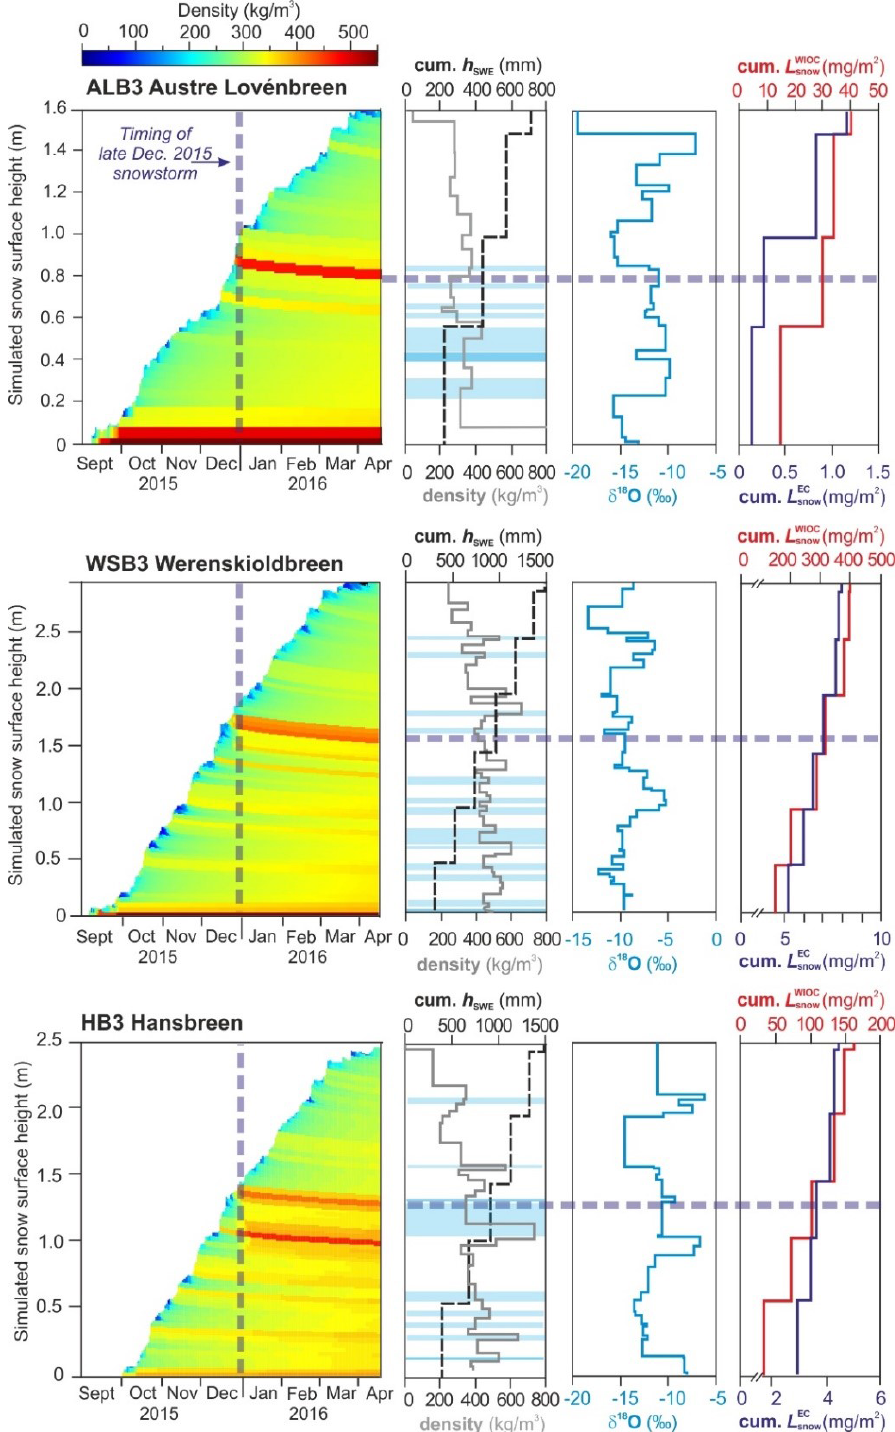
Figure 8. Simulated evolution of the snowpack from September 2015 to April 2016 at three glacier sites on Spitsbergen, compared with measured profiles of density, cumulative h SWE , δ 18 O, as well as cumulative L EC snow and L WIOC snow in the snowpack. The h SWE over the EC and WIOC sampling intervals was computed using the discrete snow layer density data. Where density measurements were missing, values from comparable layers in other snowpits were used. Snow layers with C EC snow < 1ngg − 1 were assigned a value of 0.5ngg − 1 for L EC snow calculations. Icy snow and discrete ice layers are shown as pale and darker blue lines,